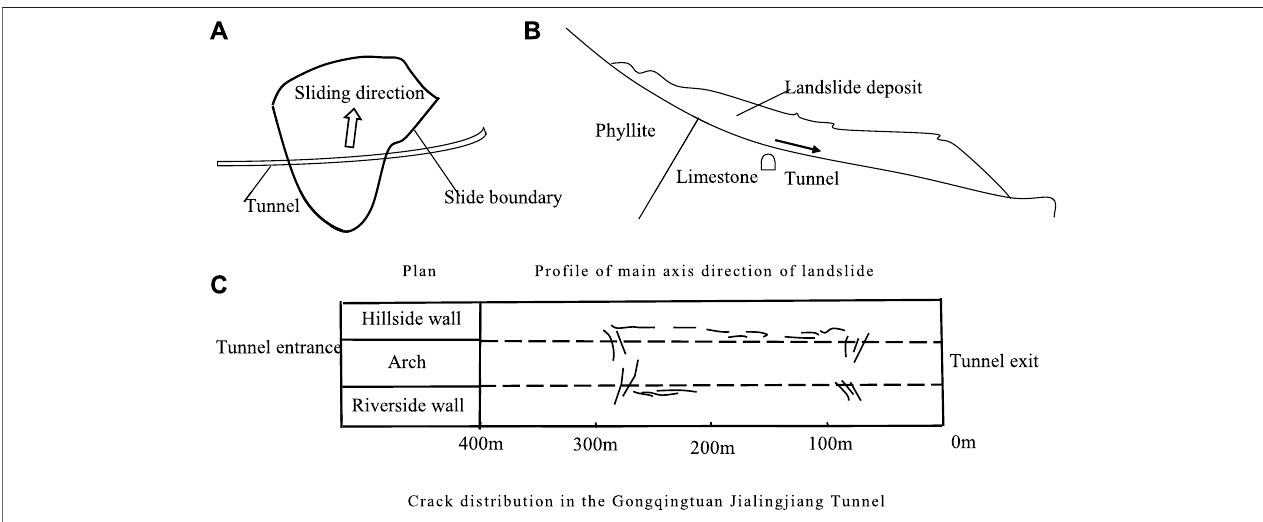
FIGURE 4 | Gongqingtuan Jialingjiang tunnel and the Nanshan landslide